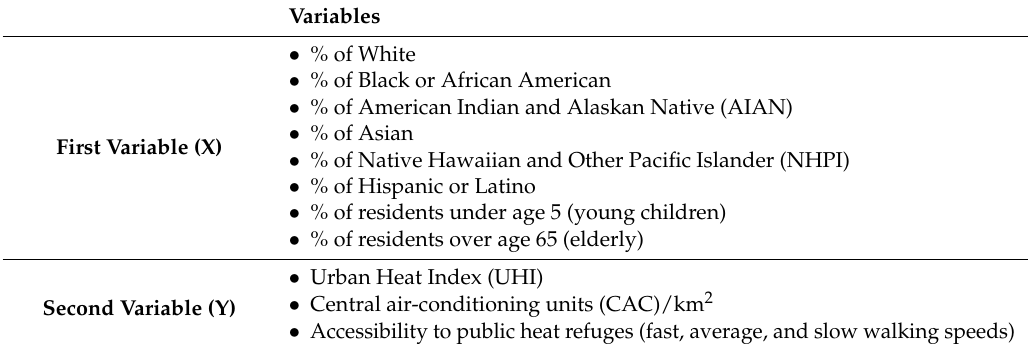
Table 1. Variables used in covariance analysis. Socio-demographic factors represented as X variables (independent); Heat refuge factors represented as Y variables